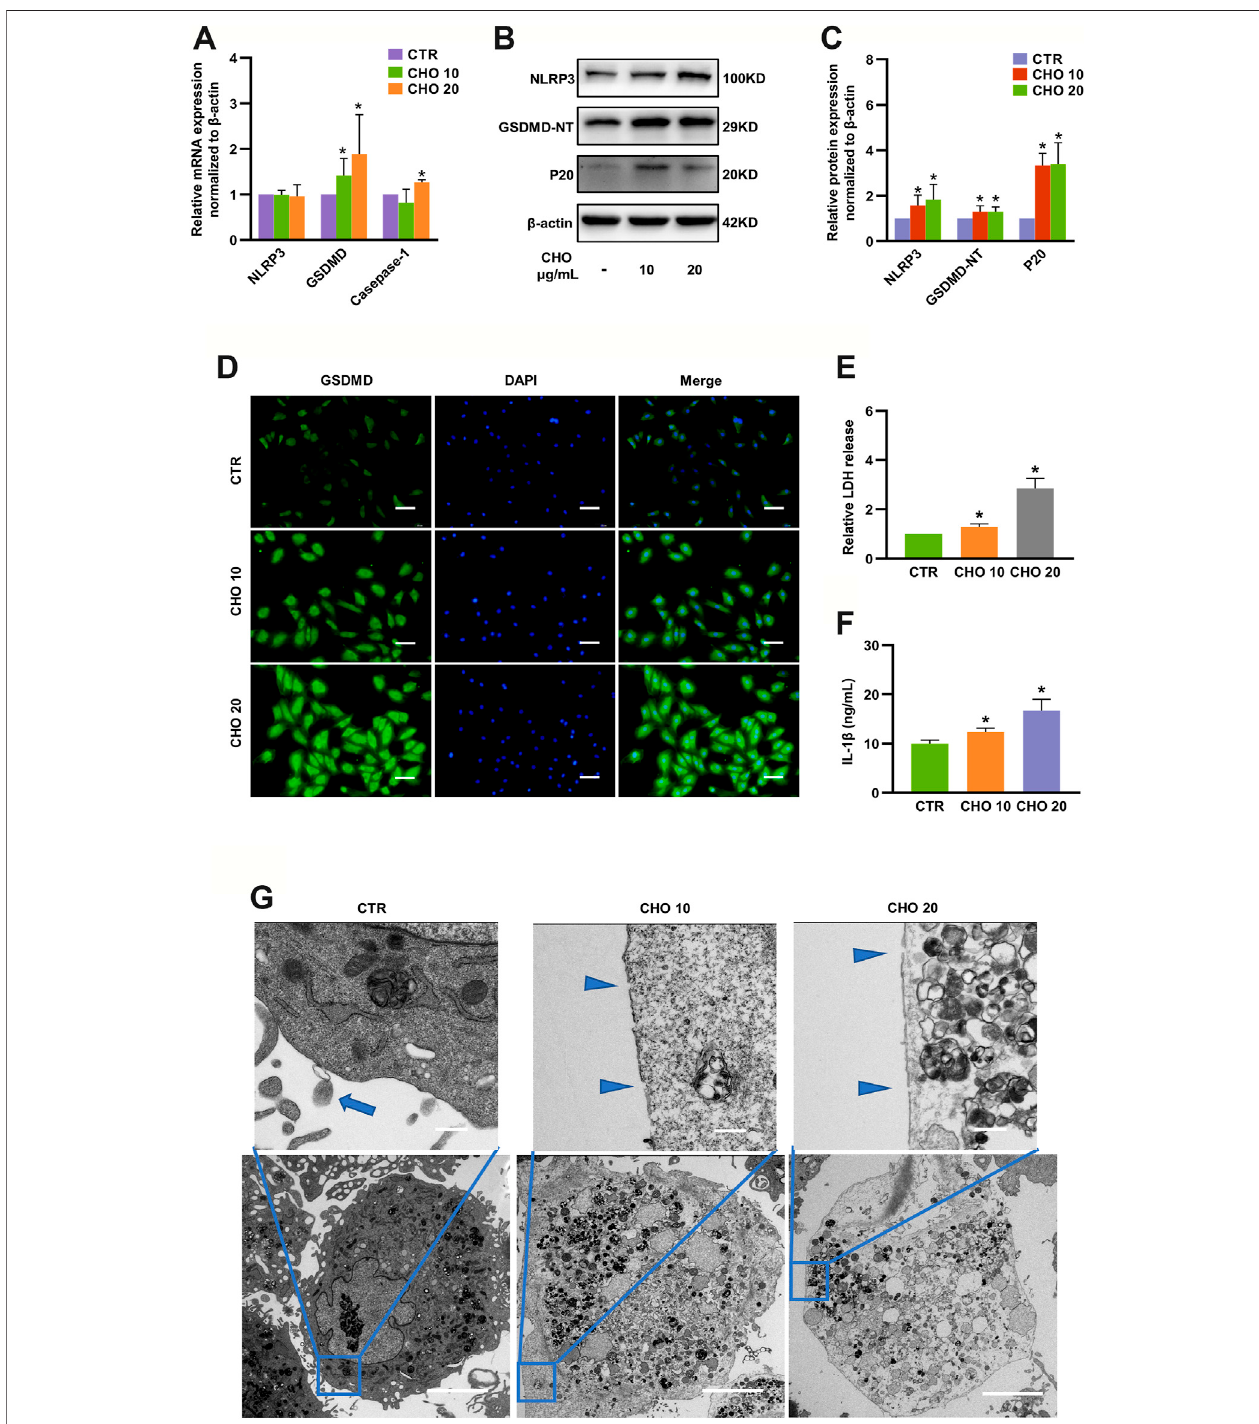
FIGURE3| CholesteroltriggerspyroptosisinratNPcells. (A) AnalysisofthemRNAlevelsofNLRP3,GSDMDandCaspase-1byRT-qPCR(n (cid:1) 3 – 4). (B,C) Protein expressionsofNLRP3,GSDMD-NTandp20wereupregulateduponstimulationwithcholesterolfor24h,asdetectedbyimmunoblotting,andwerenormalizedtothose of control cells (n (cid:1) 3 – 4). (D) Immuno fl uorescence images of NP cells stimulated with cholesterol and stained with an antibody against GSDMD (bar (cid:1) 100 μ m). (E, F) LDH and IL-1 β release in the culture supernatant was signi fi cantly increased in response to increasing concentrations of cholesterol (n (cid:1) 3). (G) TEM images of NP cells (upper panel, bar (cid:1) 500 nm; lower panel, bar (cid:1) 5 μ m). Control cells showed intact cell membranes with cytoplasmic protrusions (blue arrows). Cholesterol- stimulated cells were characterized by cell swelling and smooth cell membranes with pores (blue triangles). The data are presented as the mean ± SD. * p < 0.05.